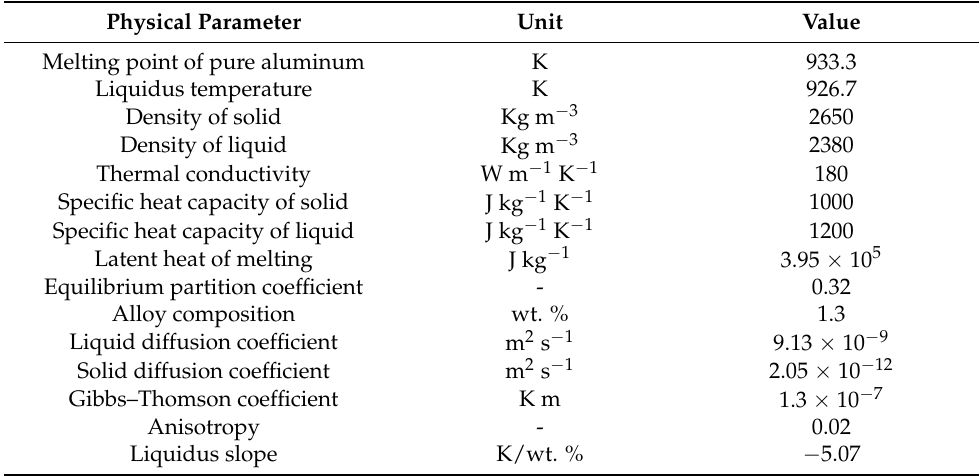
Table 2. Physical parameters of the Al–Mg alloy prepared for the heat transfer calculation and PF simulations